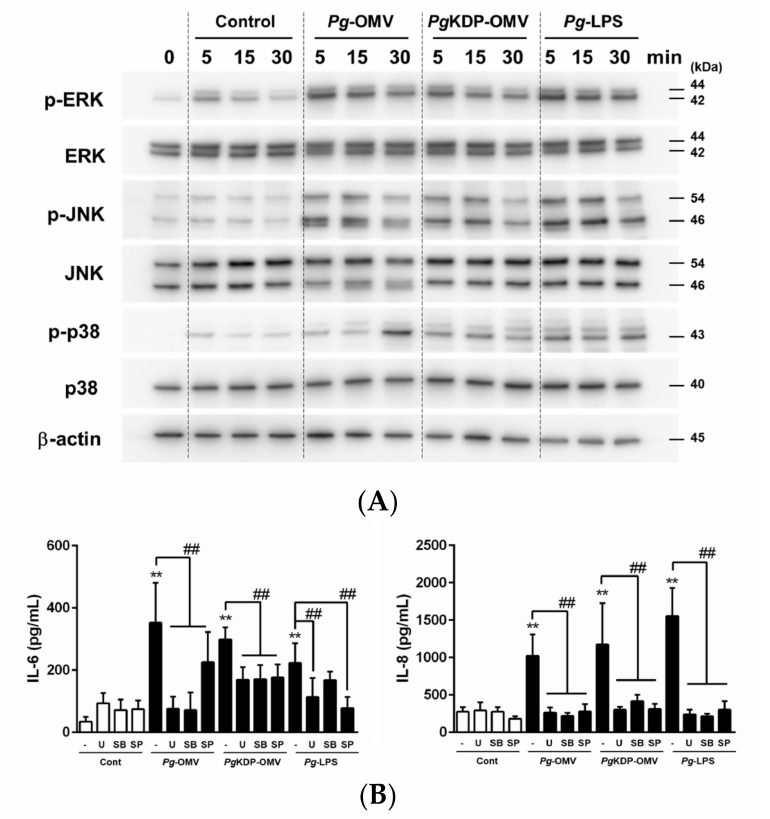
Figure 3. Pathways contributing to the induction of IL-6 and IL-8 production by Pg -OMVs, Pg KDP-OMVs, or Pg -LPS in OBA-9 cells. ( A ) OBA-9 cells were cultured with Pg -OMVs, Pg KDP-OMVs, or 100 ng/mL of Pg -LPS for 5, 15, and 30 min each8. The amount of OMVs added to cells was determined by using the same level of endotoxin activity as 100 ng/mL of Pg -LPS. Phospho- rylated mitogen-activated protein kinases (MAPKs) (Erk1/2, JNK, and p38) were assessed by Western blotting. Representative blots are shown. ( B ) OBA-9 cells were pre-treated with U0126 (10 µ M), SP600125 (20 µ M), or SB203580 (10 µ M) for 1 h before the addition of Pg -OMVs, Pg KDP-OMVs, or 100 ng/mL of Pg -LPS, for 6 h. IL-6 and IL-8 concentrations in the cell culture supernatants were determined using an ELISA program. Data are the mean ± SD of three independent experiments. ** p < 0.01 compared to the unstimulated control. ## p < 0.01 compared to the control without